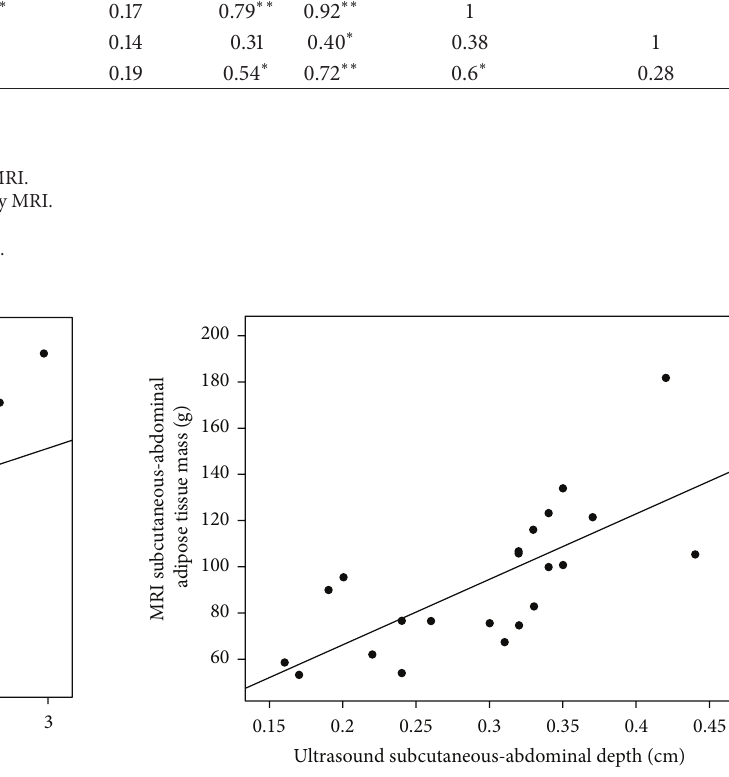
Figure1: Scatterplot ofultrasoundvisceral depth against MRIintra- abdominal adipose tissue (IAT-AT) mass. Correlation coefficient: 𝑟 = 0.48 ; 𝑃 = 0.02 .